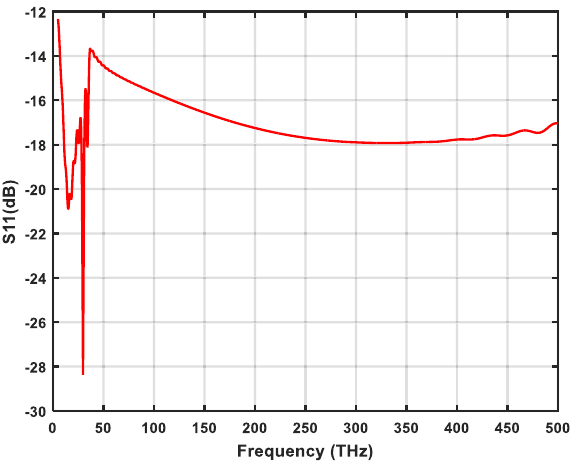
Fig. 3 Permittivity of the graphene using Drude model a real part of permittivity b Imaginary part of permittivity Fig. 4 S 11 parameters of graphene nano patch